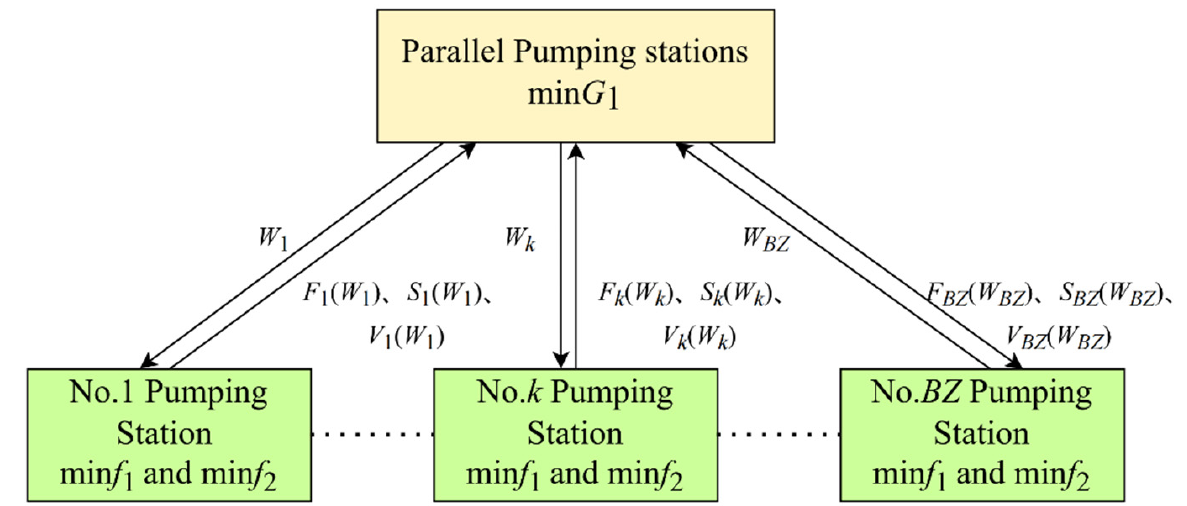
Figure 1. Schematic diagram of subsystem aggregation.